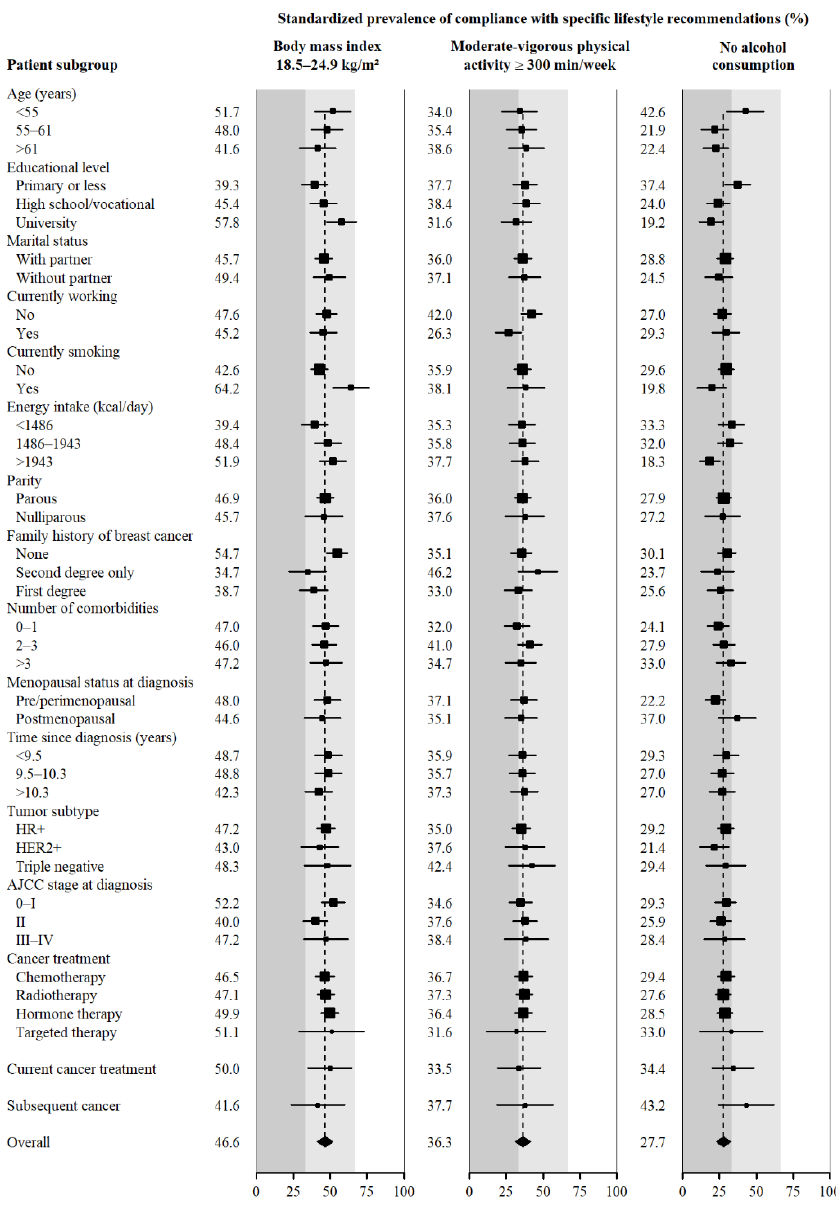
Figure 1. Standardised prevalence of high compliance with specific lifestyle recommendations by sociodemographic and clinical characteristics of breast cancer survivors (%). Standardised prevalence (95% CI) to the overall distribution of age, recruiting region, educational level, marital status, currently working, currently smoking, caloric intake, parity, family history of breast cancer, number of comorbidities, menopausal status at diagnosis, years since diagnosis, tumour subtype, AJCC stage at diagnosis, current cancer treatment and the overall adherence to the other recommendations in the entire sample of breast cancer survivors.